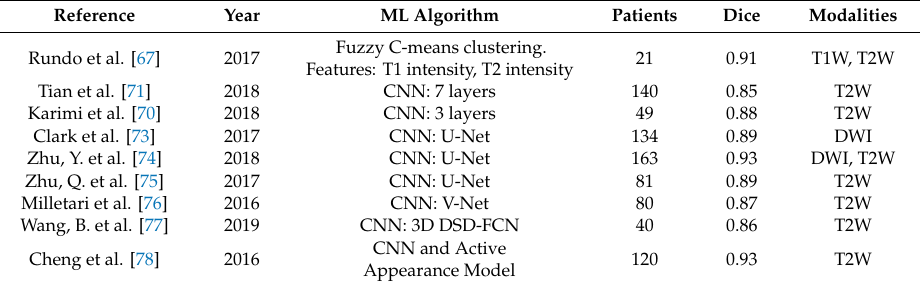
Table 1. Machine learning techniques applied to prostate organ